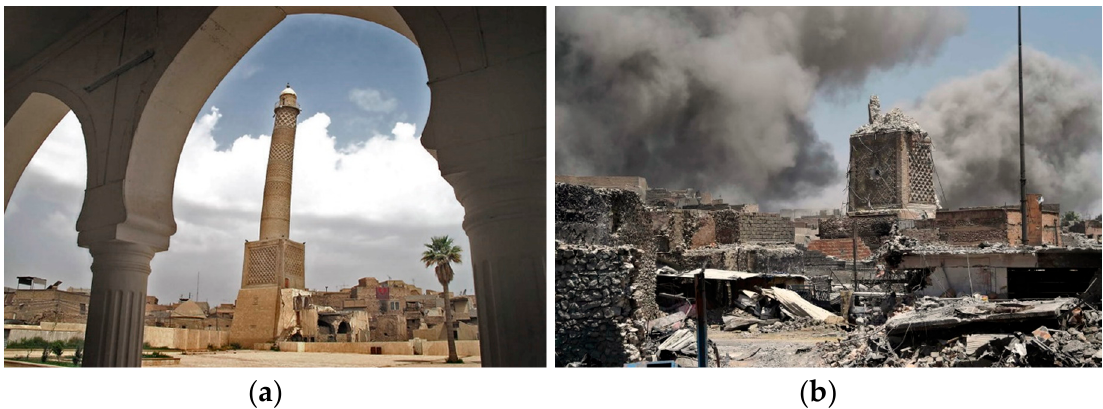
Figure 15. Al-Nuri Grand Mosque in the Old City of Mosul, Iraq. ( a ) before destruction. ( b ) after destruction [27].